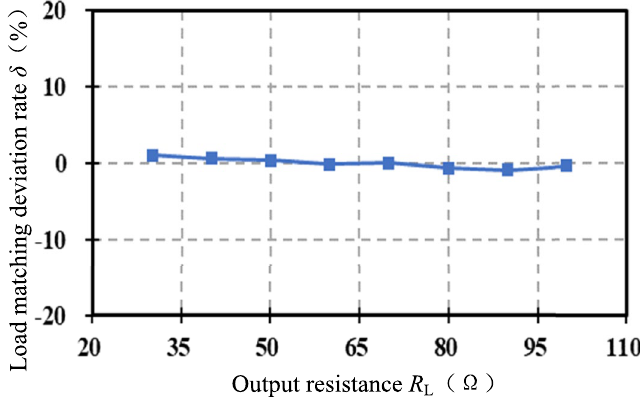
Figure 12. Load matching deviation rate when R L changes.